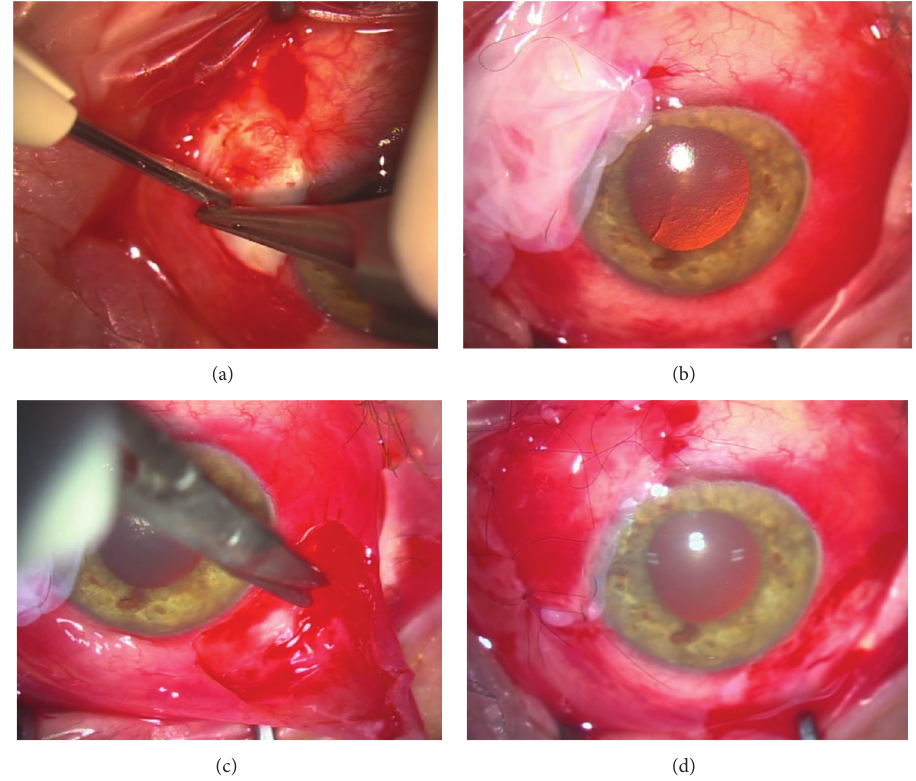
Figure 3: (a) A large area of conjunctiva surrounding the stent was excised and mild diathermy was applied over the scleral area. (b) A double layer of amniotic membrane was sutured over the dissected area. (c) After ballooning the conjunctiva with lidocaine, a larger patch of conjunctiva was excised in the inferotemporal quadrant to serve as a graft. (d) The graft was sutured over the amniotic membrane with 10-0 nylon interrupted sutures.